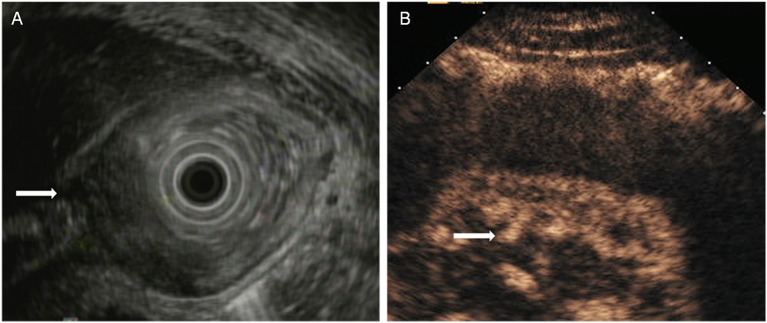
A case with T3 tumor located in the gastric angle. (A) EUS showed an large lesion with a thickness of approximately 3 cm penetrated the serosal layer. (B) DCEUS showed the lesion penetrated the serosa (arrow) with disappearance of all layers.